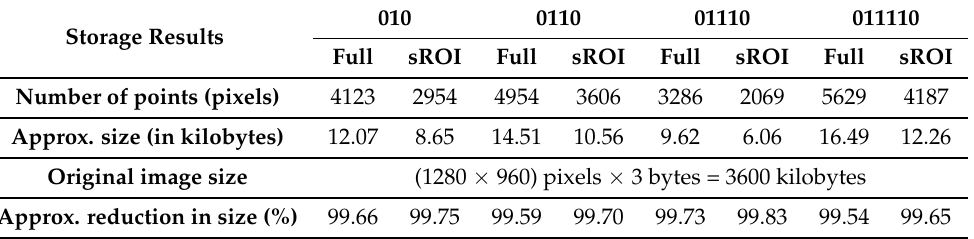
Figure 10. Comparison of the storage sizes (in kilobytes, KB) of compressed images with our change-driven approach and with the usual JPEG compression process. The models evaluated were the ones generated by the 010, 0110, 01110, and 011110 binary patterns, whereas the JPEG quality factors considered were 10, 30, 50, 70, and 90. The graph shows the mean size of the compressed images. Table 2. Storage results for full models and sROIs at the 6th-MRL, which includes regions at the 6th, 7th, and 8th refinement